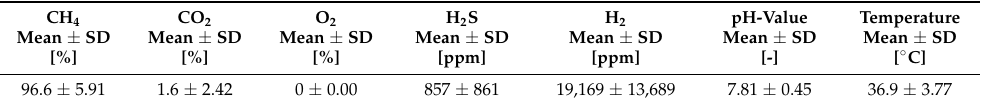
Table 6. Product gas composition and operational parameters during the normal operation phase of the biofilm reactor (days